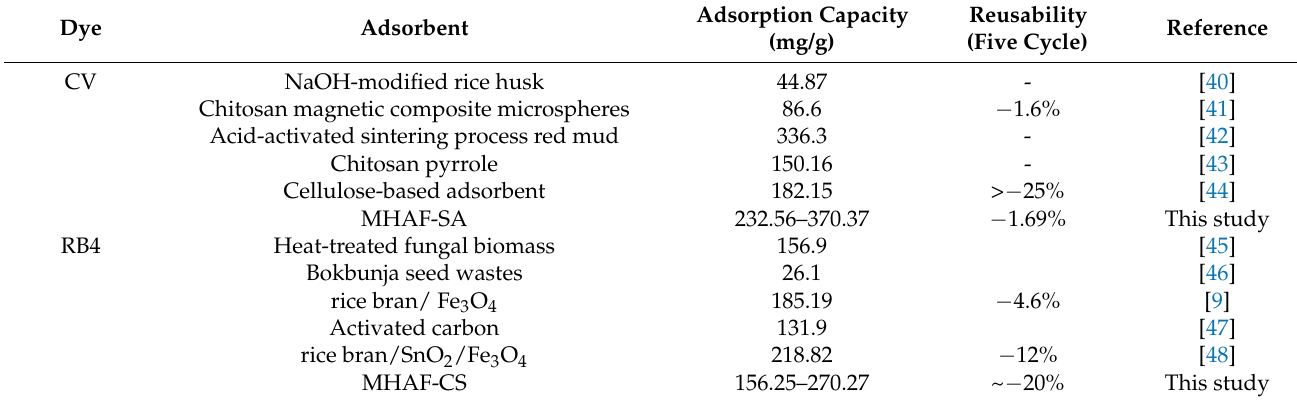
Table 3. Comparison of adsorption capacity of various